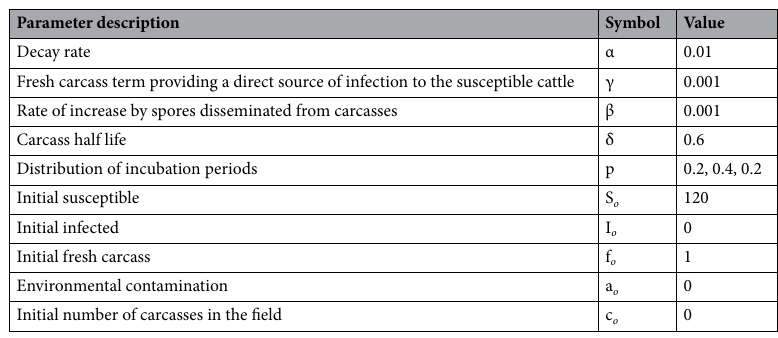
Table 1. Model parameters and